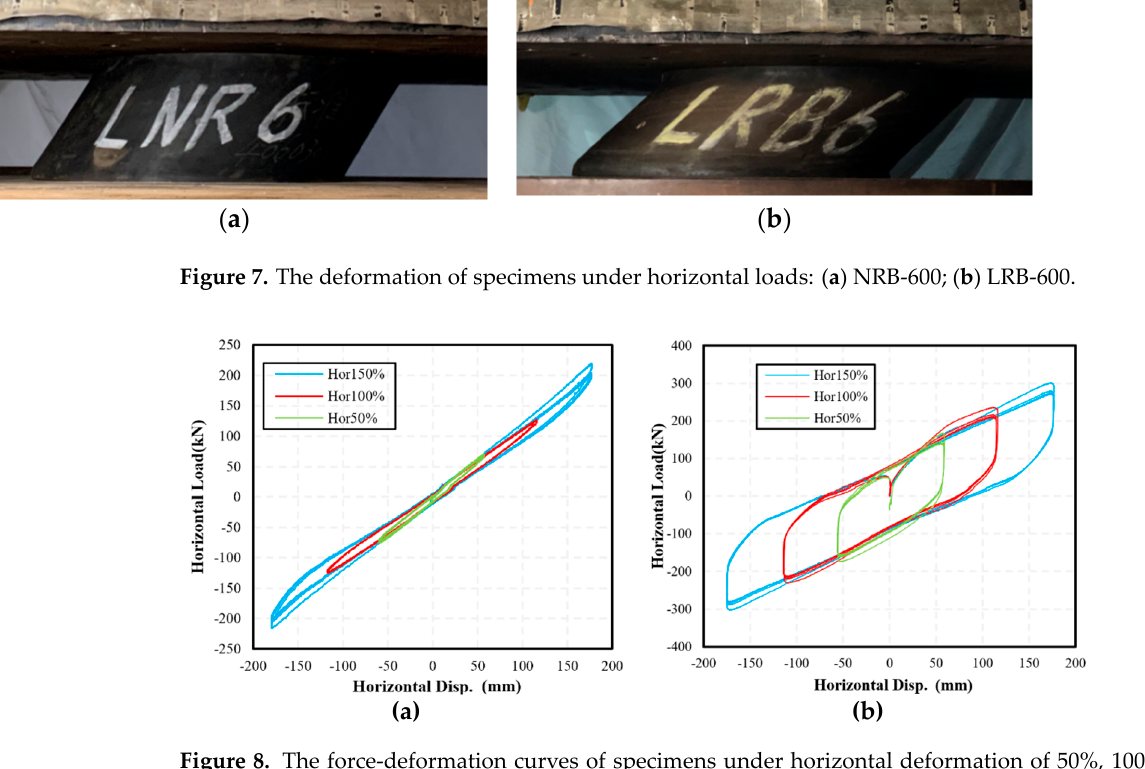
Figure 8. The force ‐ deformation curves of specimens under horizontal deformation of 50%, 100% Figure 8. The force‑deformation curves of specimens under horizontal deformation of 50%, and 150% shear strain: ( a ) NRB ‐ 600; ( b ) LRB ‐ 600. Table 5. Mechanical properties of the specimen obtained in the horizontal shear tests